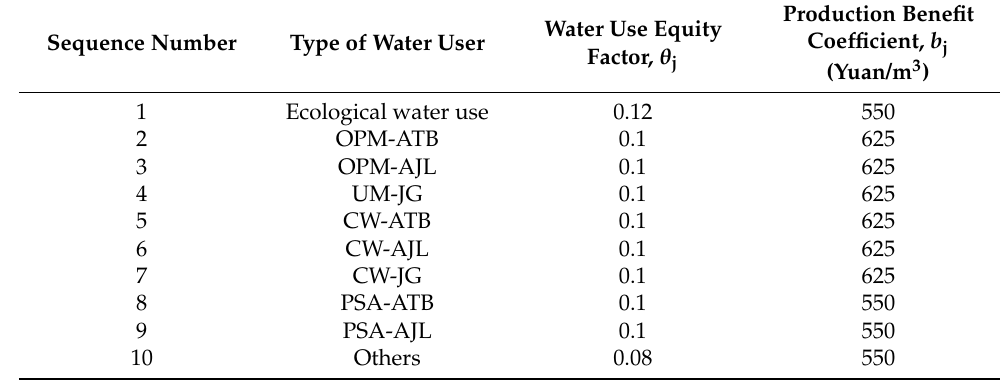
Table 9. Parameters of different water users. The meaning of the abbreviations is shown in Table